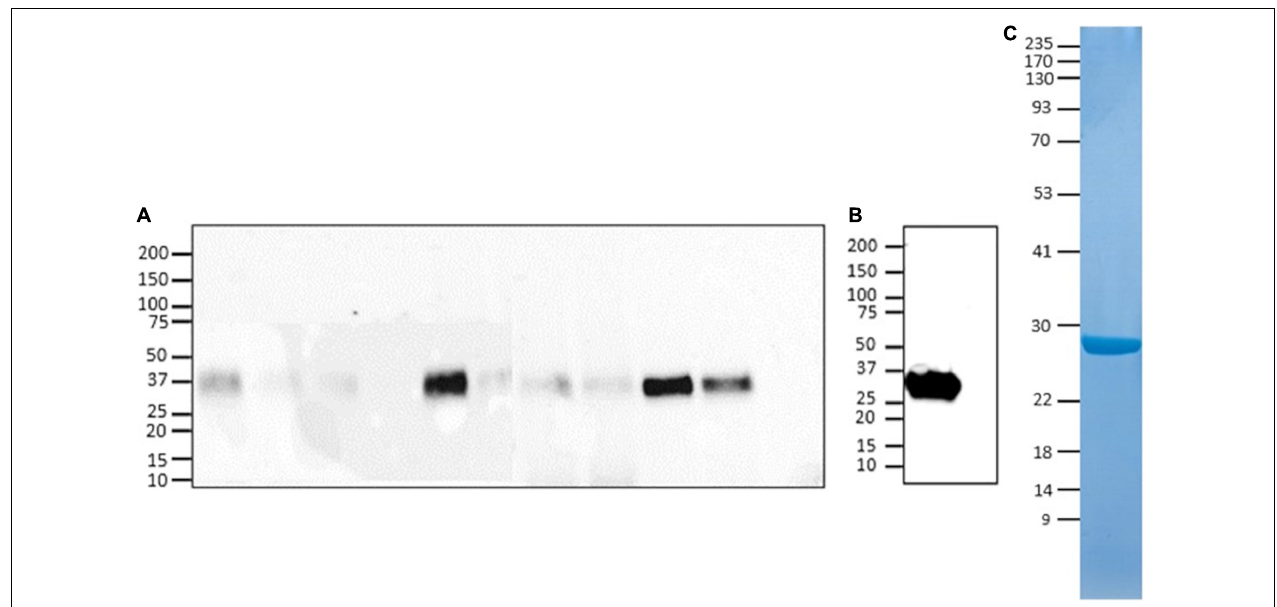
FIGURE 1 | Evaluation of Lt-RBD protein production in L. tarentolae . (A) Expression analyses of Lt-RBD in the concentrated supernatant of 10 engineered L. tarentolae clones. A band of approximately 35 kDa is visible using an anti–His-tag antibody. (B,C) Analysis of Lt-RBD protein expression, purified by affinity chromatography, and confirmed by Western Blotting using an anti–SARS/SARS-CoV-2 Coronavirus Spike Protein antibody (B) and by SDS-PAGE with Coomassie staining (C) .